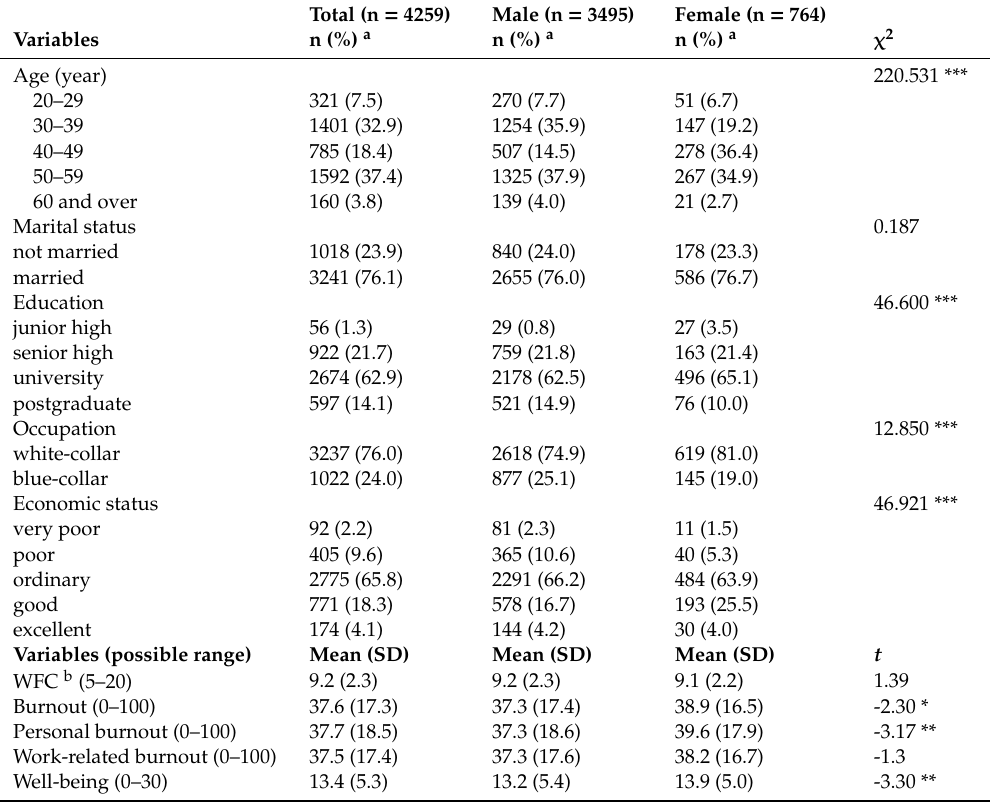
Table 1. Comparing demographic characteristics and research variables by gender.